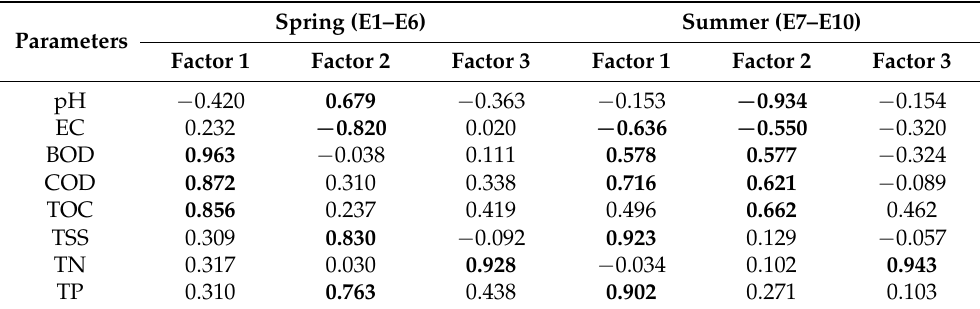
Table 3. Principal component loadings of observed water quality parameters in the immediate post-fire period.